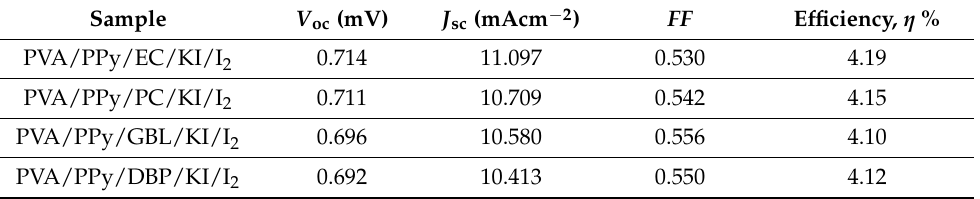
Figure 8. Photo current density ( J )–voltage ( V ) curves for the DSSCs fabricated with the PVA/PPy/KI/I 2 electrolyte containing various plasticizers (in wt.%); ( a ) EC, ( b ) PC, ( c ) GBL, and ( d ) DBP. Table 5. Photo-voltaic parameters of fabricated DSSCs composed of different plasticized polymer